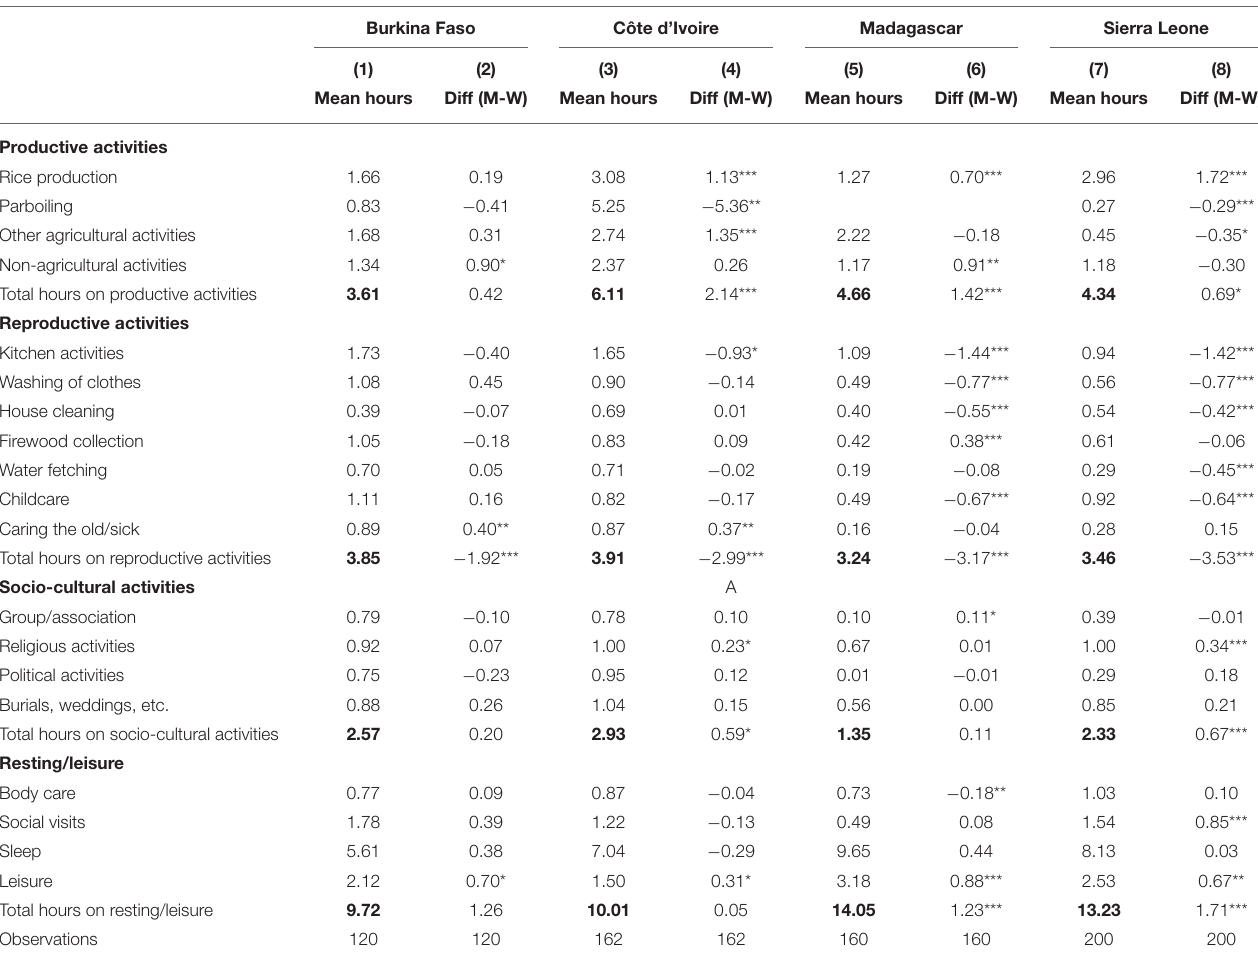
TABLE 3 | Time allocation in Burkina Faso, Côte d’Ivoire, Madagascar, and Sierra Leone. Burkina Faso Côte d’Ivoire Madagascar Sierra